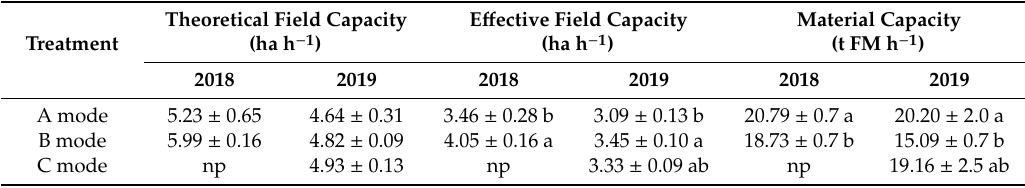
Table 4. Baler performance in 2018 and 2019 according to the treatments (common letters within columns denote the absence of significant di ff erence (p < 0.05)).